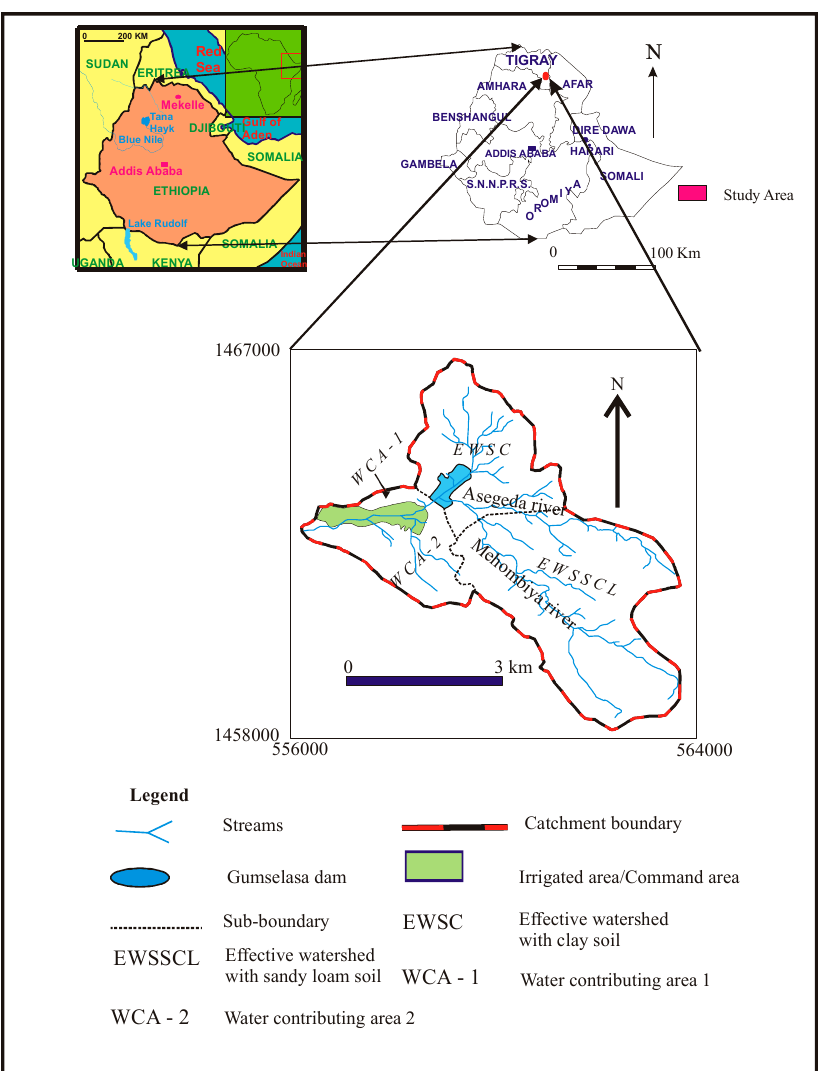
Figure 1. Location map of the study area (source: modified after Nata [30]).